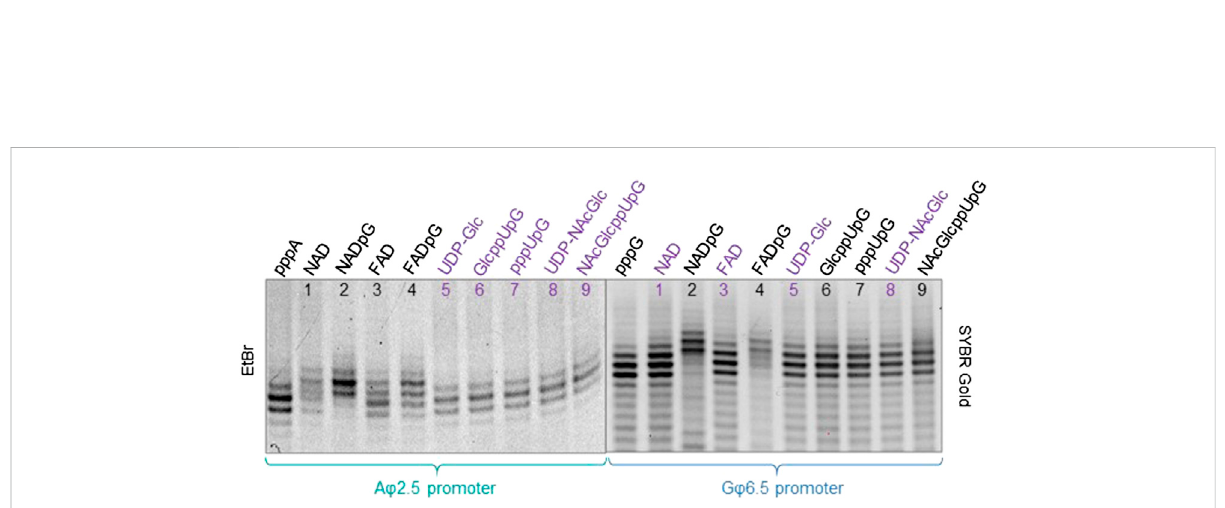
FIGURE 3 High resolution polyacrylamide gel electrophoresis (HRPAGE; 15% PAA, 7 M urea, 1 # TBE) analysis of 35 nt IVT RNAs obtained from templates containingeithertheA φ 2.5promoter(leftgelstainedwithEthidiumBromide — EtBr)ortheG φ 6.5promoter(rightgelstainedwithSYBRGold)inthe presence of 0.5 mM NTPs, 0.125 ATP/GTP, and 0.375 mM of the initiating nucleotide analog. The purple labels correspond to the caps that are expected not to incorporate into RNA with the de fi ned